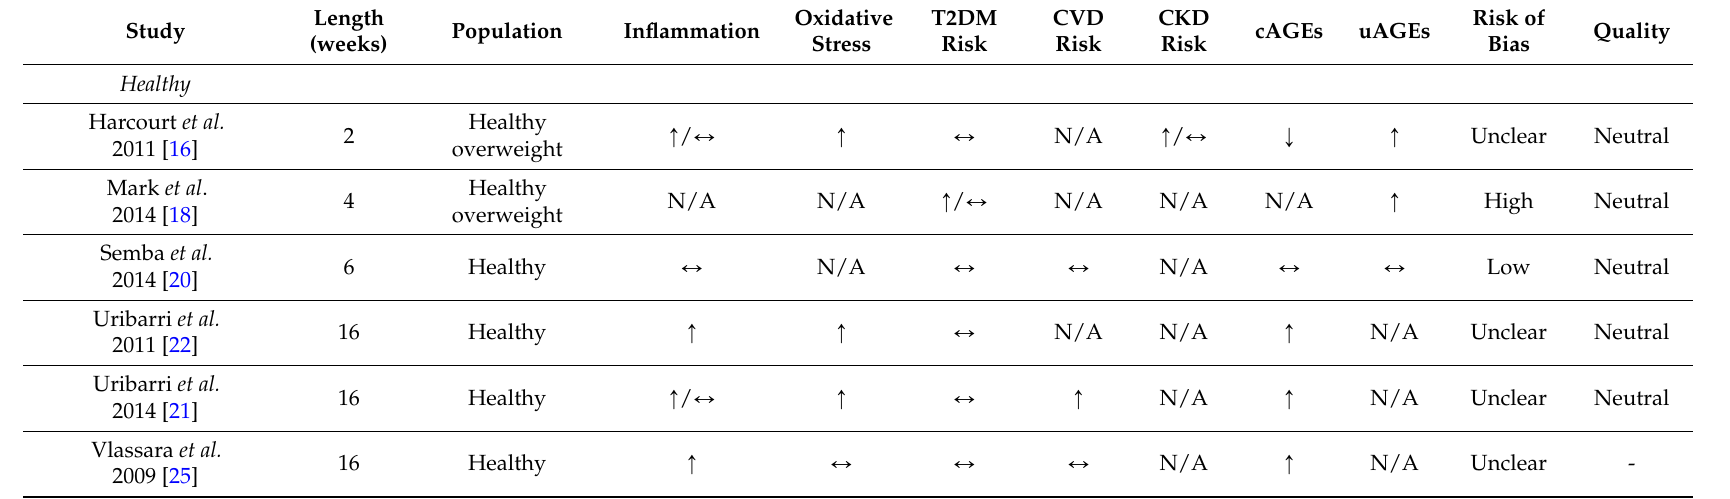
Table 6. Summary of findings from included